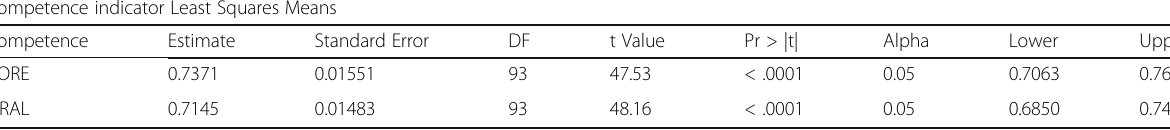
Table 5 There are no significant differences between competences